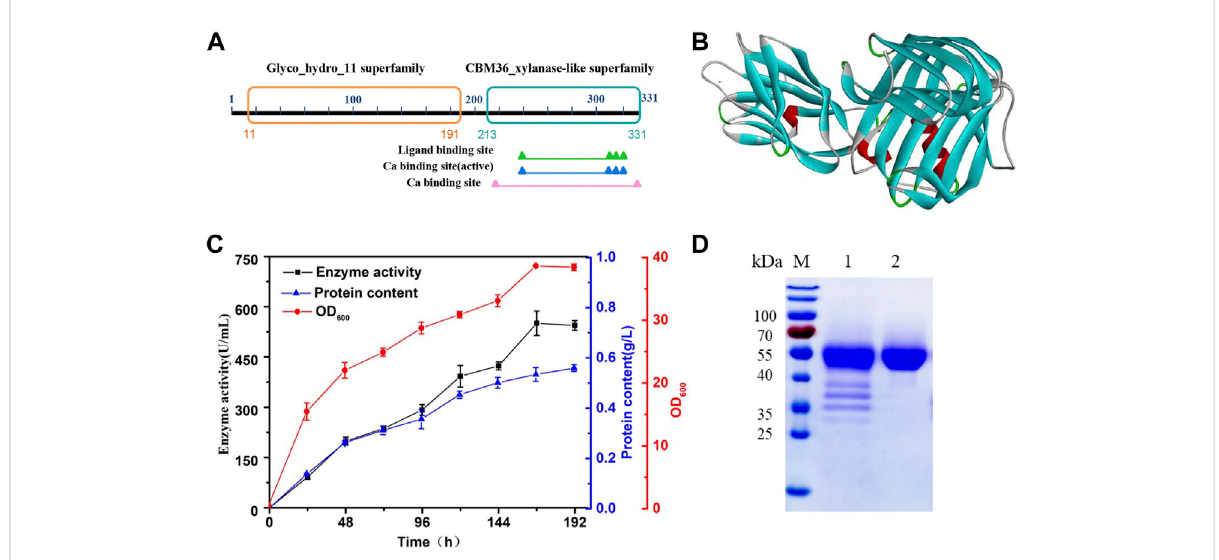
FIGURE 2 Protein sequence, three-dimensional structure, expression, and puri fi cation analysis of Hmxyn. (A) Conserved domains analysis of the amino acid sequence of Hmxyn. (B) The predicted structure of Hmxyn. Red represents ɑ -helix, blue represents β -sheet, green represents β -turn, and gray represents random coil structure. (C) Heterologous expression of Hmxyn in Pichia pastoris . (D) SDS-PAGE analysis of puri fi ed recombinant Hmxyn. Lane M, molecular markers. lane 1, crude enzyme; lane 2, puri fi ed fractions after Ni-NTA af fi nity